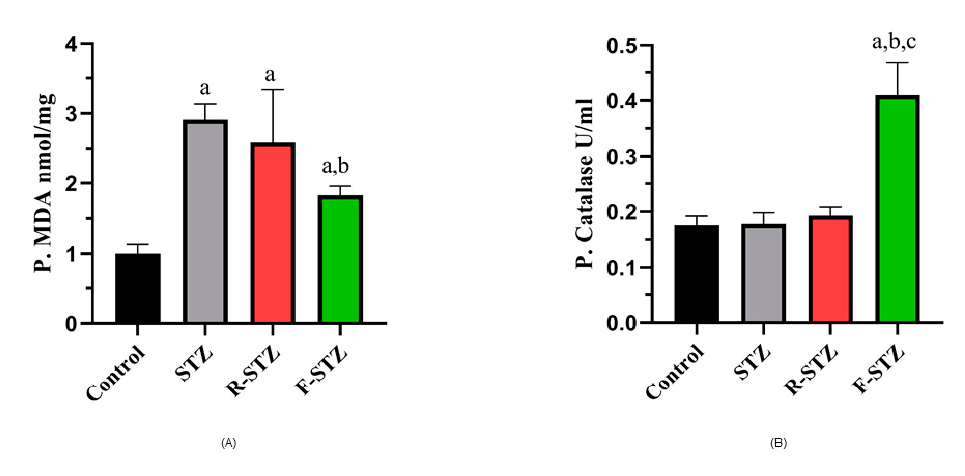
Figure 2. Pancreatic oxidative stress markers in all studied groups ( A ) Pancreatic MDA (mmol/mg); ( B ) Pancreatic CAT (U/ml). (a) Significant difference from normal control group at p < 0.05; (b) Significant difference from STZ group at p < 0.05; (c) Significant difference from R-STZ group at p < 0.05.